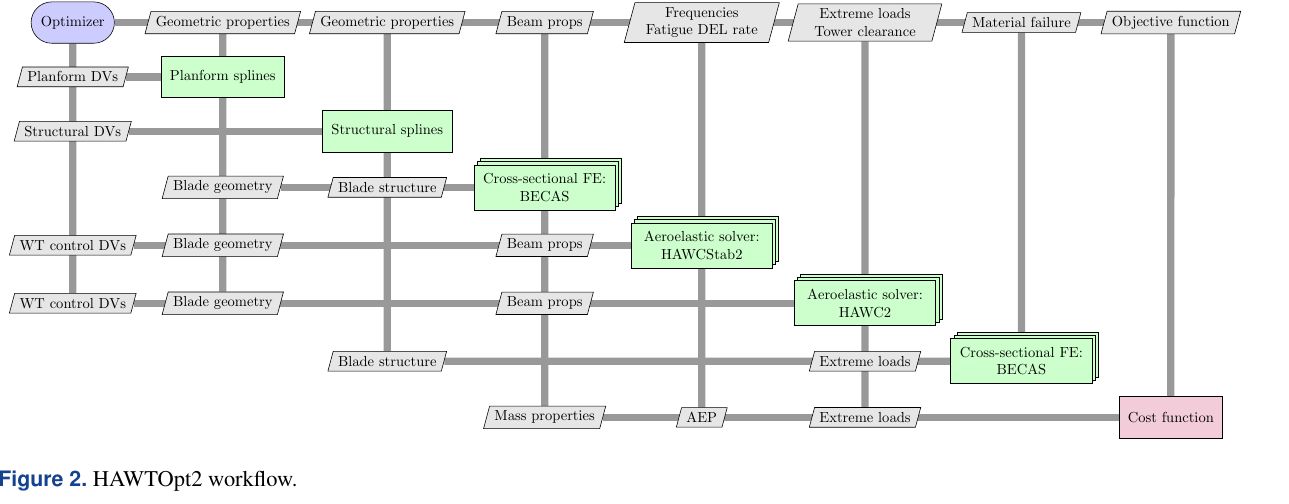
Figure 2. HAWTOpt2 workflow.